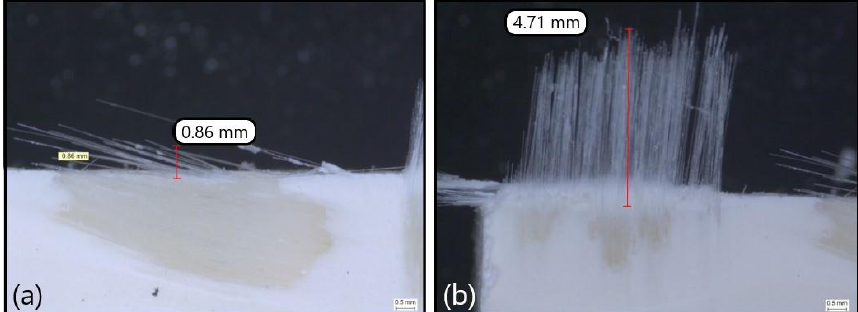
Figure 8. Illustration of the delamination depth: ( a ) type III and ( b ) type II caused by T3 at the worn state. worn state.